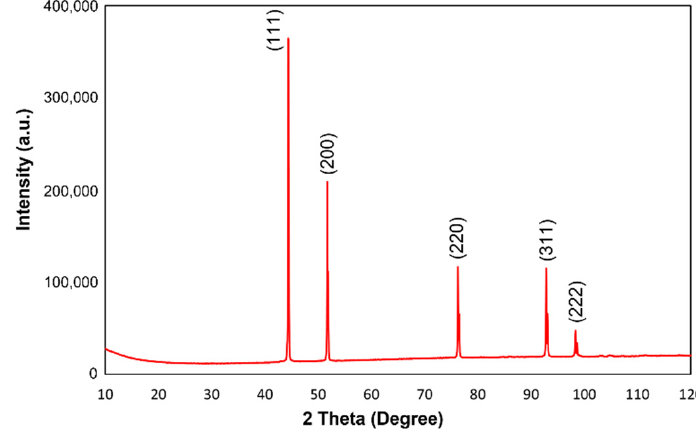
Figure 11. XRD pattern for nickel porous structure.